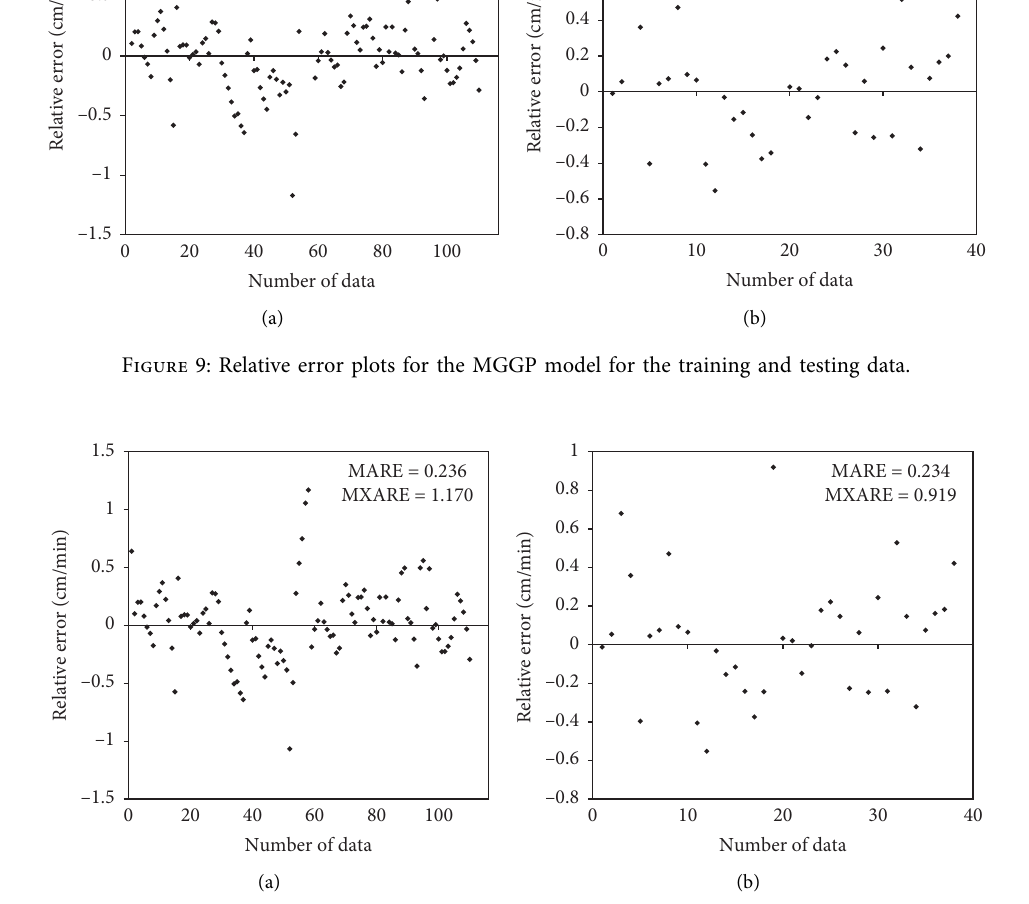
Figure 10: Relative error plots for the hybrid MGGP-GRG model for the training and testing data.